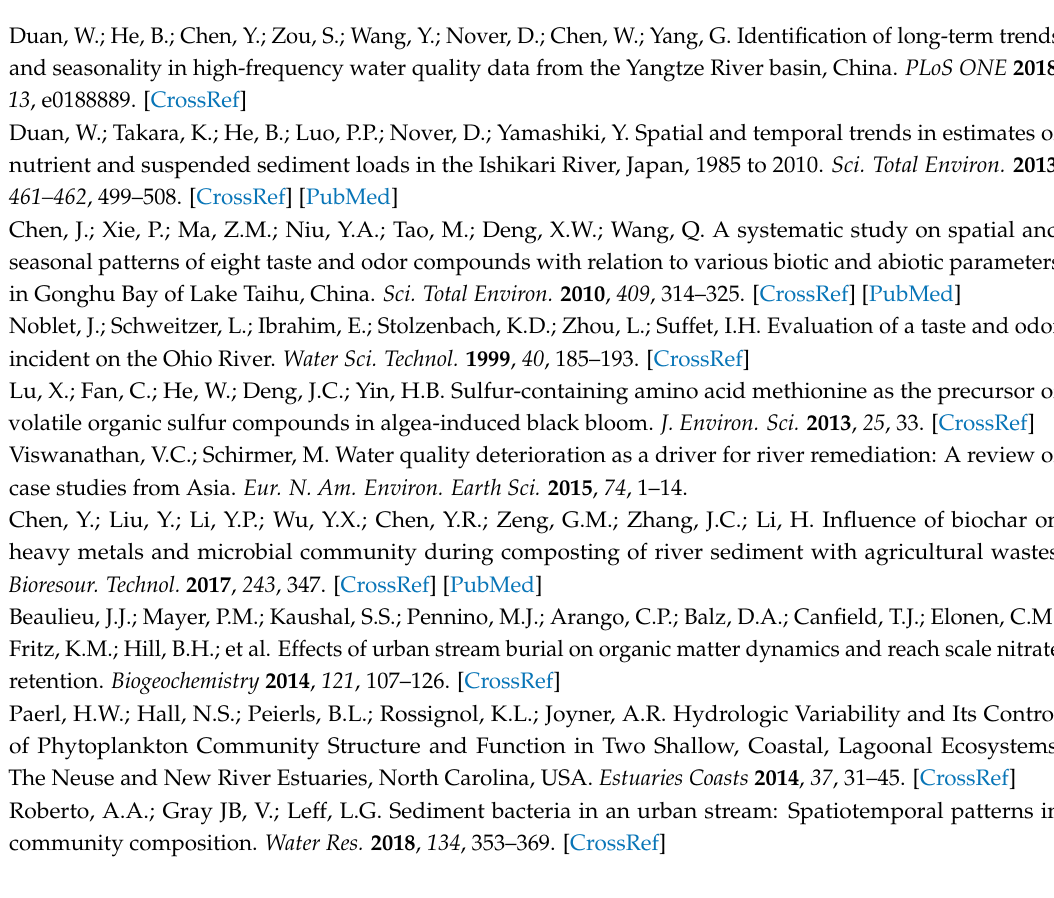
Figure S1: Monthly mean temperature of Dongguan City (2016–2018), Figure S2. The Concentration of TP (mg/L) during remediation, Table S1. The ACE and Chao 1 index of